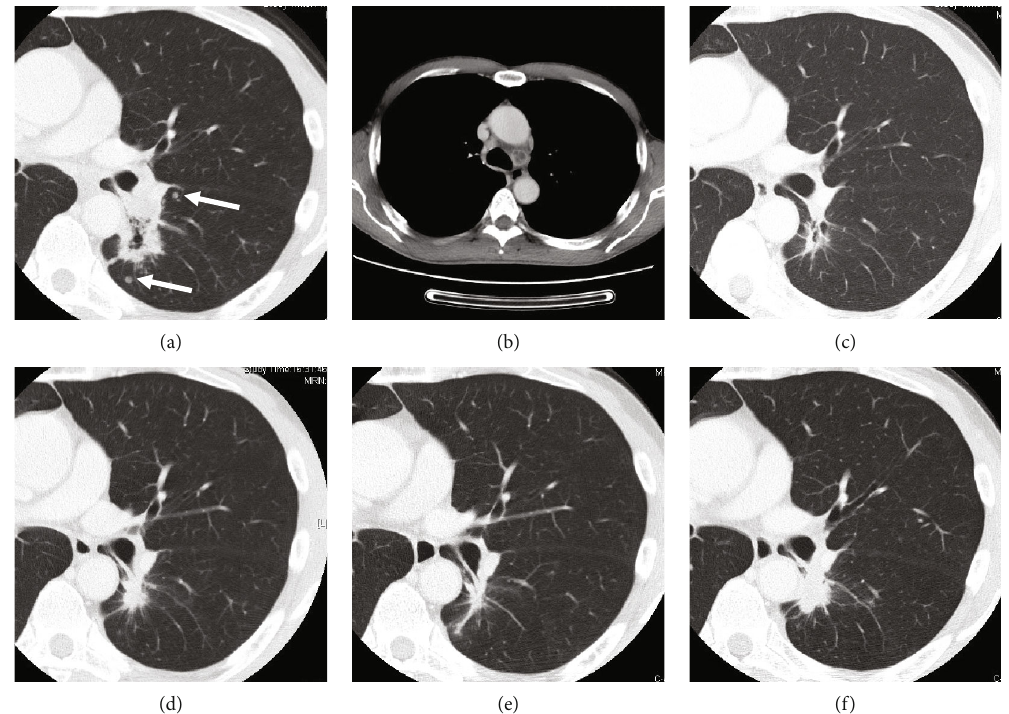
Figure 1: Chest CT scan. Chest CT scan performed on admission (a, b) four months after afatinib treatment (c) before the initiation of ge fi tinib (d) two months after ge fi tinib treatment (e) and six months after ge fi tinib treatment (f). Arrows indicate separate tumor nodules in the same lobe as the primary